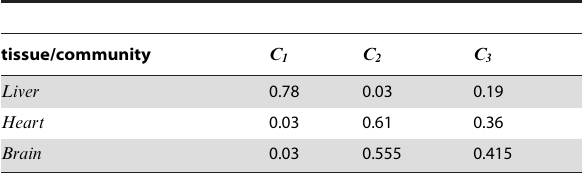
Table 11. Percentage of tissue samples assigned by NetSel to each